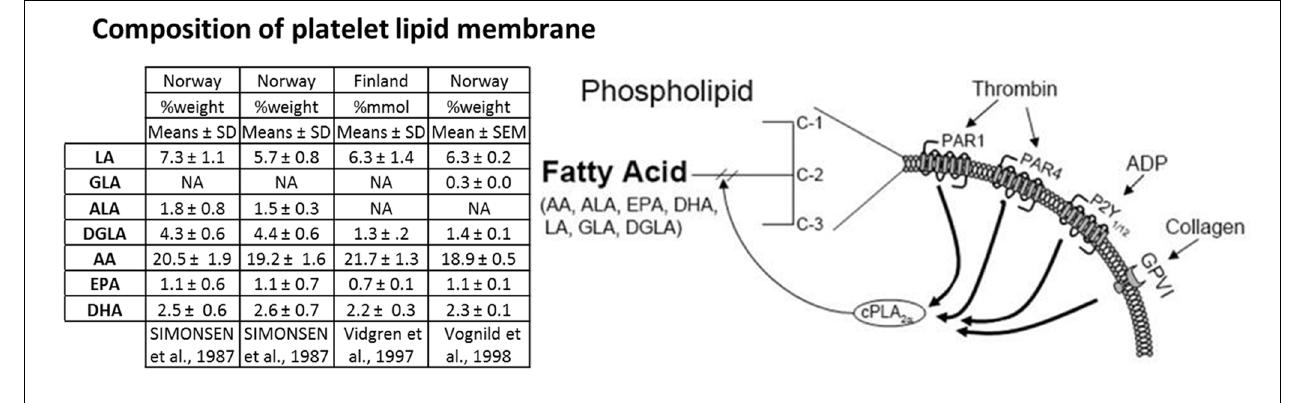
communities (column 2) in northern Norway. Liberation of PUFAs from the platelet membrane is achieved in an agonist dependent manner. Platelet stimulation through a myriad of agonists including thrombin, ADP, and collagen cause the translocation of cPLA 2 α to the plasma membrane where it cleaves PUFAs from the plasma membrane to generate free PUFAs, which can be metabolized to